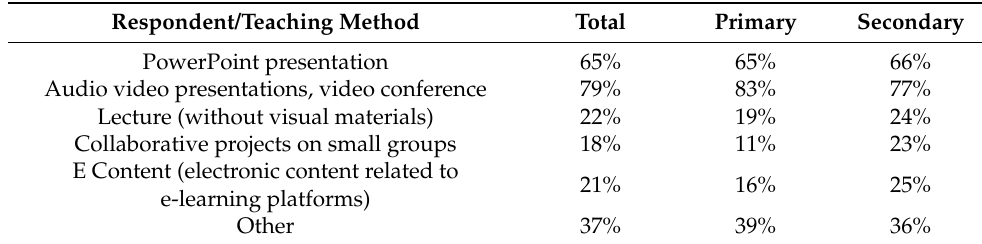
Table 10. Teaching method used during the COVID 19 pandemic (question